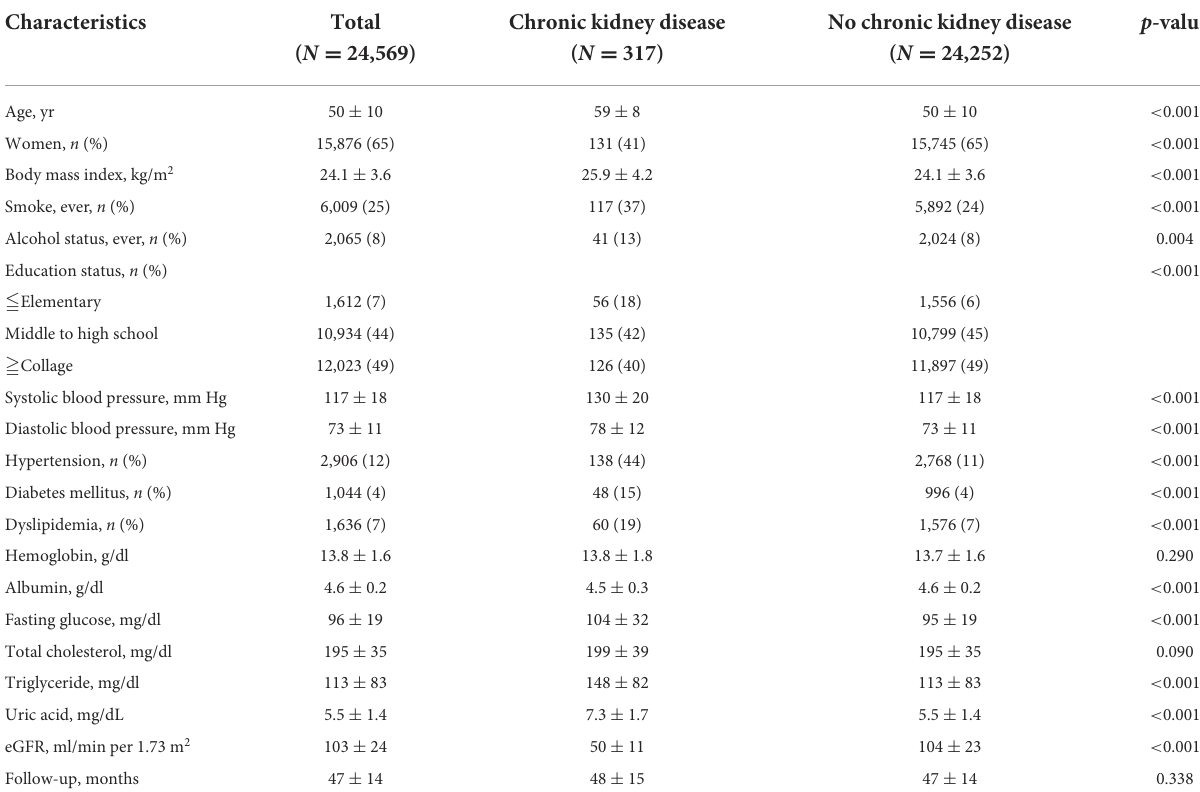
TABLE 3 Clinical characteristics of the longitudinal cohort ( n = 24,569).